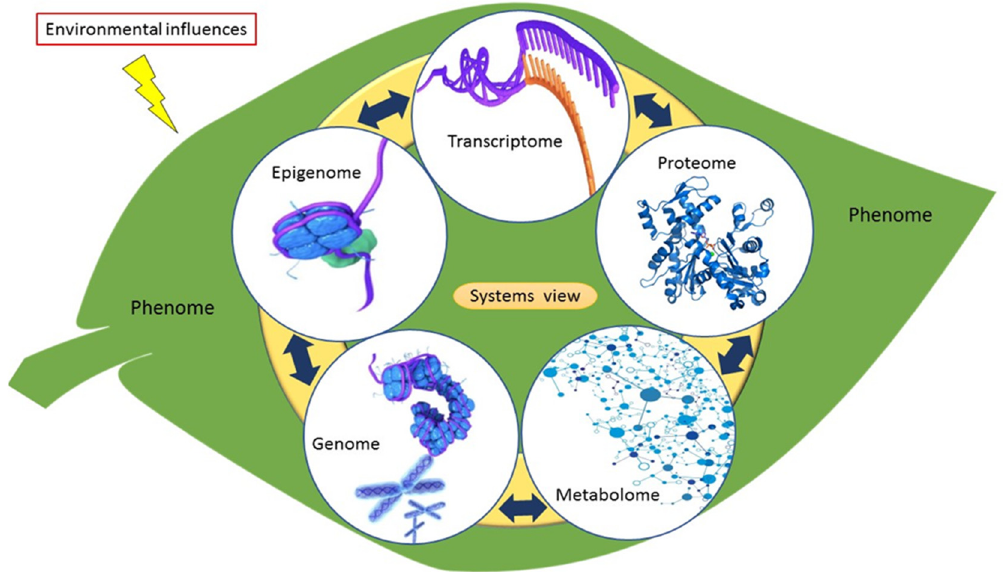
Figure 6. Systems overview and interconnectedness of cardinal omics approaches. The metabolome is the downstream output representing the physiological state of the phenotype resulting from the direct flow of biological information. The downstream output represented by the metabolome not only reflects the integration of the genome, epigenome, transcriptome and proteome output, but also the input from environmental influences such as abiotic stress.